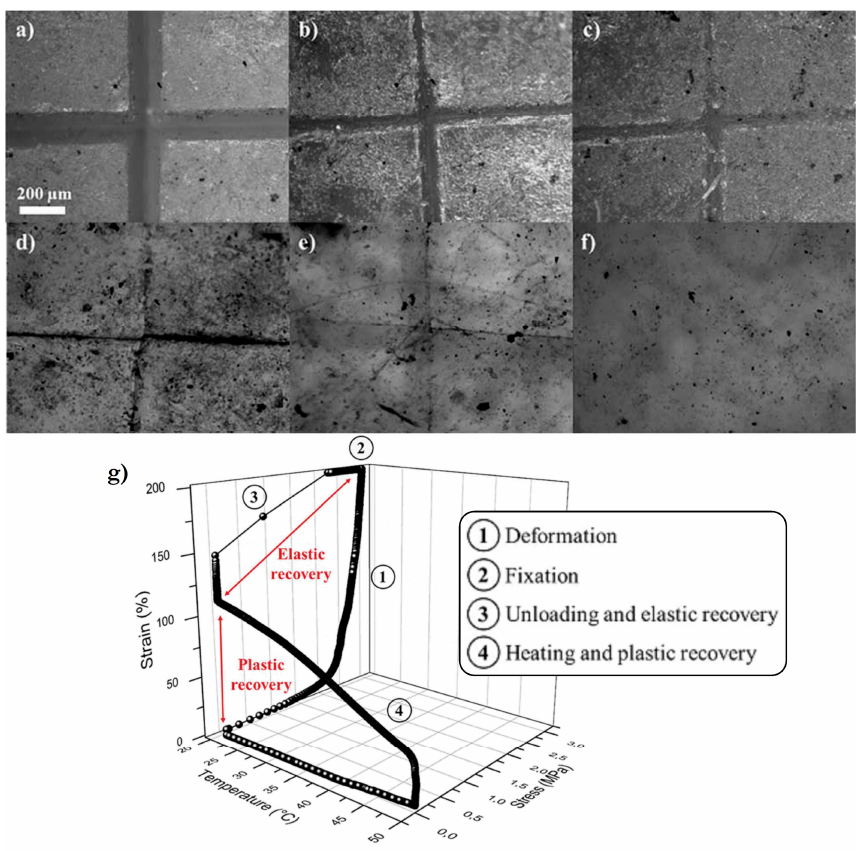
Figure 11. Microscopic images of the nanocomposites immediately after a scratch damage was inferred ( a ); and after being held at 50 °C for 1 h ( b ); 2 h ( c ); 3 h ( d ); 4 h ( e ) and 5 h ( f ); demonstrating the self-healing behavior. Cyclic stress-controlled thermomechanical test of the nanocomposite showing reversible plasticity/shape–memory ( g ) [156] (Reprinted from Ref. [156] with permission of The Royal Society of Chemistry.).